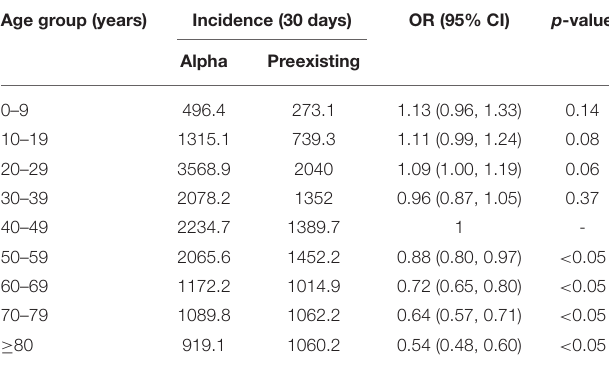
TABLE 1 | Odds ratios of putative cases of variant alpha COVID-19 by age group.